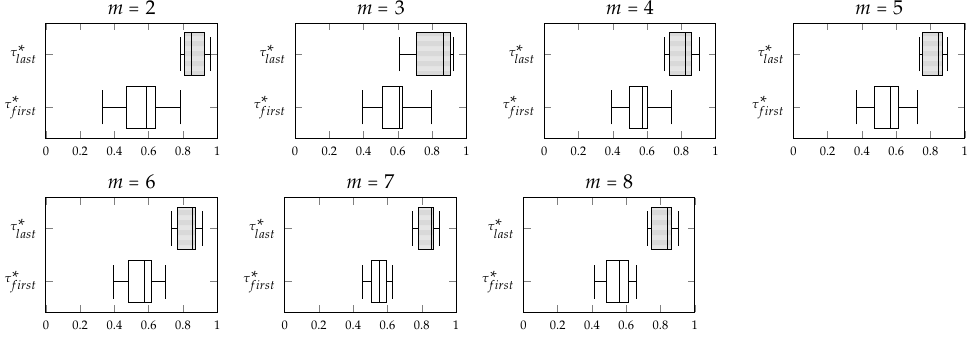
Figure 6. Variation of the concordance indices τ ∗ of experts m (Category corn).